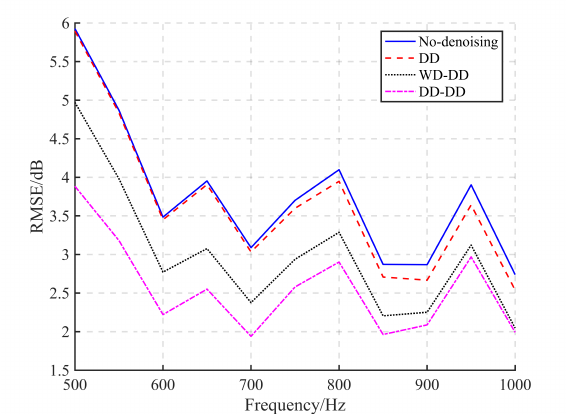
Figure 9. The variation of RMSE with the